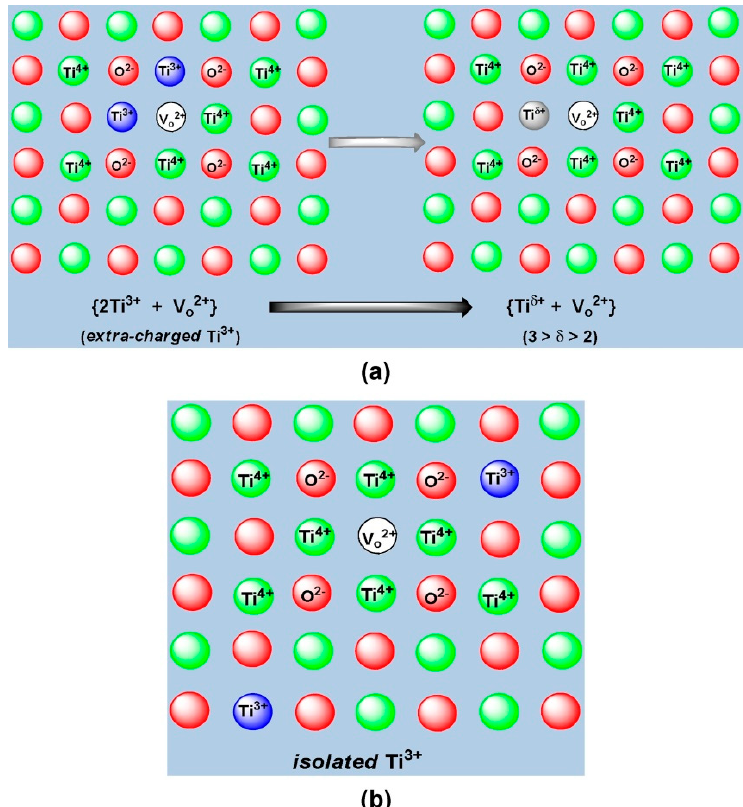
Figure 60. Cartoons representing the meaning of: ( a ) extra-negatively charged Ti 3+ as being the complex formed between two adjacent Ti 3+ species neighboring an oxygen vacancy (V o ) that can be viewed as a Ti δ + center with 3 > δ > 2; and ( b ) isolated Ti 3+ centers. Reproduced with permission from